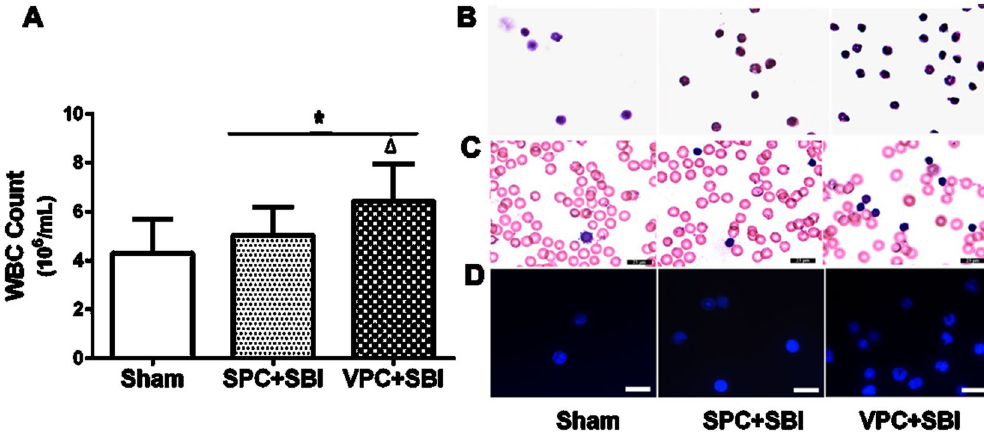
Figure 3. Total peripheral WBC count and peripheral WBC suspension staining 24 h after SBI. (A) Total peripheral WBC count was increased in VPC + SBI group compared to Sham and SPC + SBI groups. * p < 0.05 vs Sham, ∆ p < 0.05 vs SPC + SBI. Data are shown as mean ± SD. n = 8/group. (B) Hematoxylin and eosin (H&E) staining (n = 3/group) (C) Wrights staining (n = 3/group) and (D) DAPI staining (n = 3/group) of peripheral WBC suspension showing segmented granulocytes in VPC + SBI group. All scale bars = 25 μ